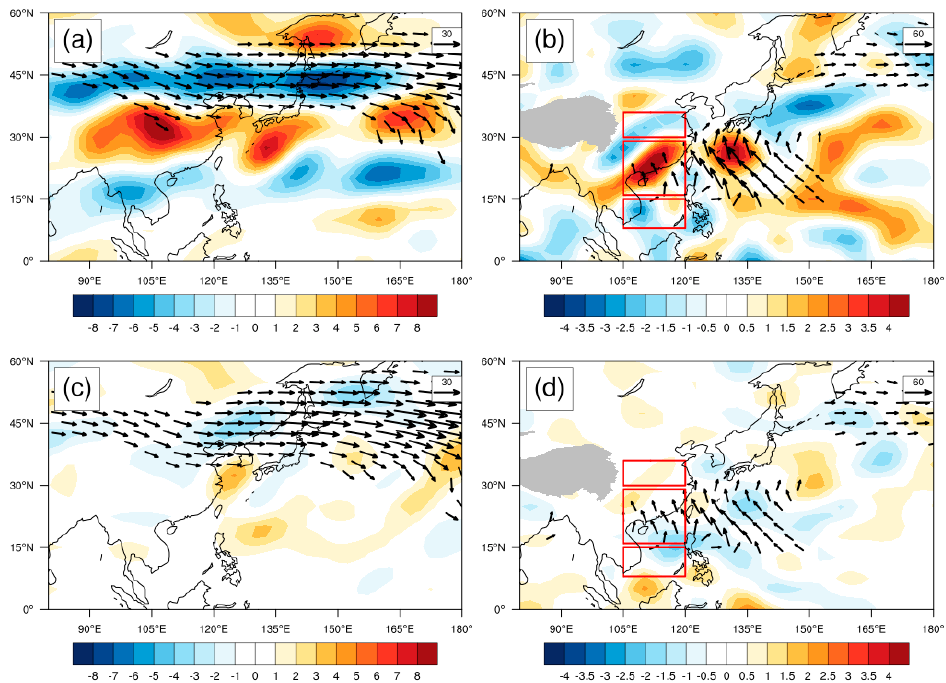
Figure 7. Composite anomalies of relative vorticity (shading, unit : 10 − 6 s − 1 ) and associated WAF (vectors, unit : m 2 s − 2 ) at ( a , c ) 200 and ( b , d ) 850 hPa in wet years of S1 ( a , b ) and S2 ( c , d ) (significant values exceeding the 95% confidence level are displayed).